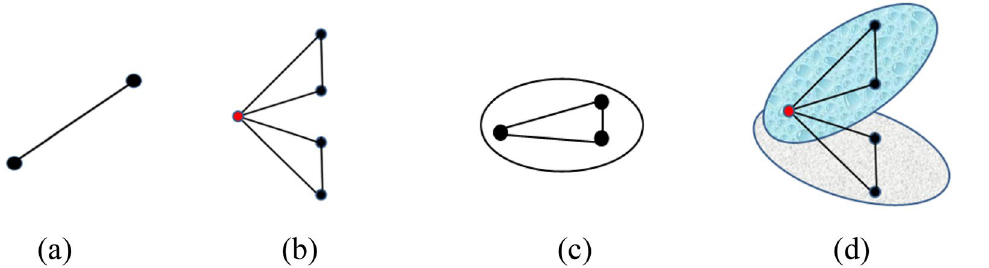
Figure 1. Different game relationships are expressed by network structure. Nodes and edges/hyperedges represent players and game relationships, respectively: ( a ) edge of complex network represents pairwise game relationship between two players; ( b ) degree of nodes in complex network show that player play a game with multiple opponents; ( c ) hyperedge shows that players participate in single-group game in hypernetwork and nodes in hyperedge are fully connected; ( d ) hyperdegree of nodes can divide the neighbors into different groups to show player participates in multiple-group game. The red node is the hub node or the overlapping node which can show the heterogeneous nature of realistic game relationship because it has more neighbors than other